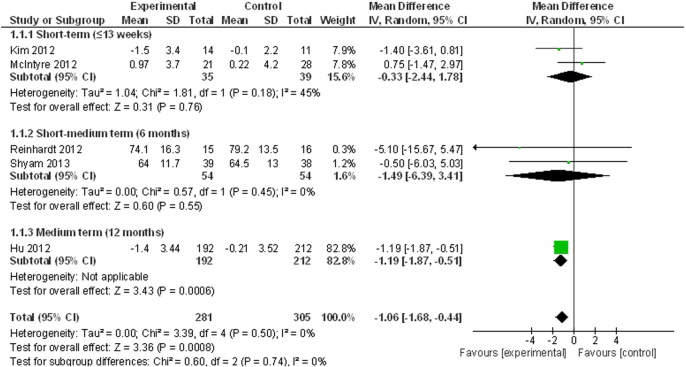
Meta-analysis of weight loss.